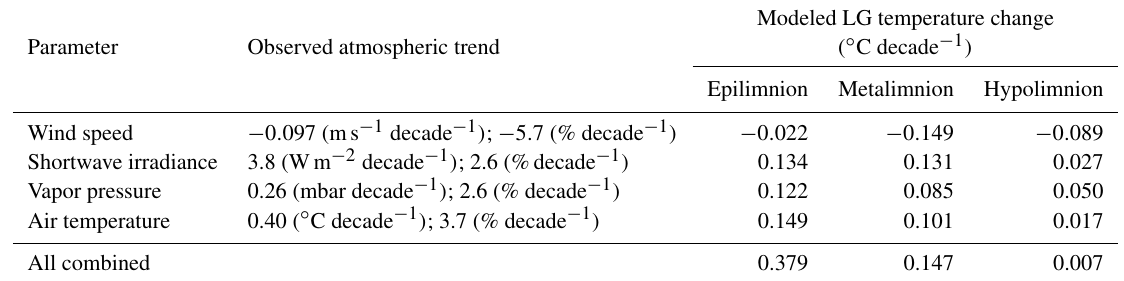
Table 6. Observed trends in atmospheric forcing (1981 to 2013) at station no. 8100 (Fig. 2) per decade, and modeled temperature increase in Lake Geneva (LG) with forcing trends applied to the reference period (1990 to